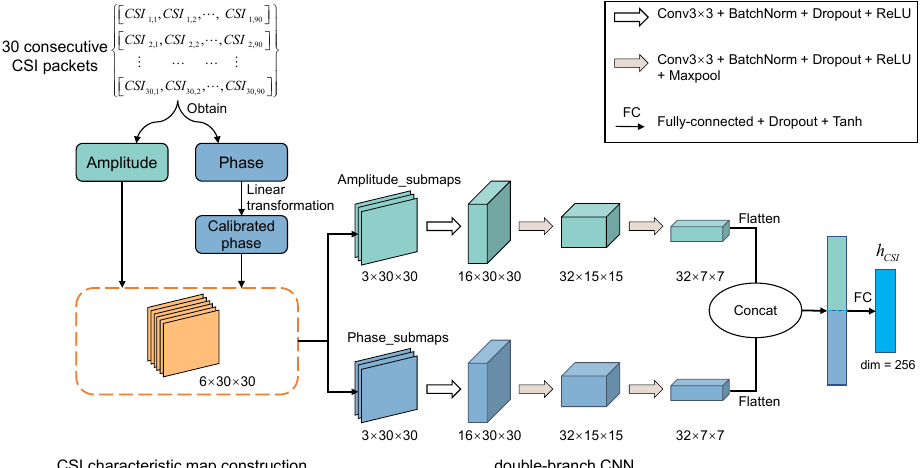
Figure 3. CSI feature extraction subnetwork, including CSI characteristic map construction and a double-branch CNN structure. The network outputs the feature vector containing CSI-specific location